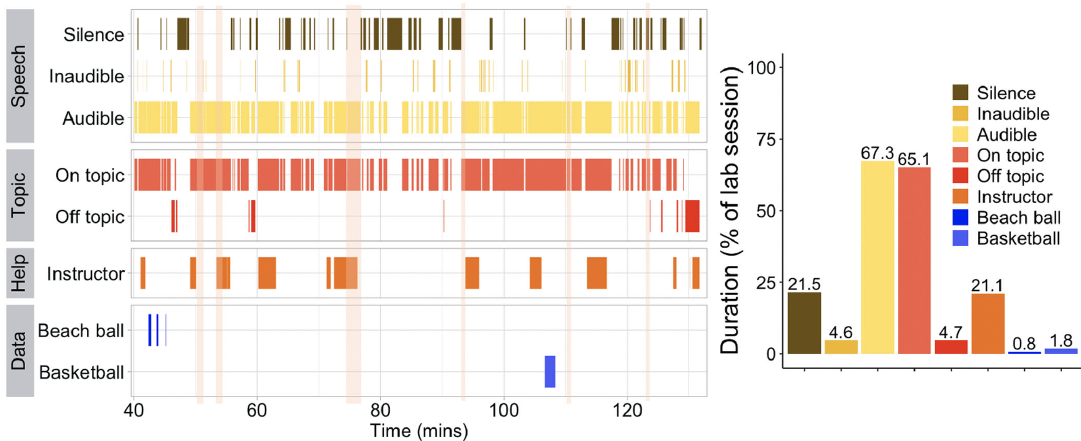
FIG. 15. Group F full timeline and durations of each behavior as a percentage of the video analyzed. The portions analyzed in Sec. V B 2 are highlighted.